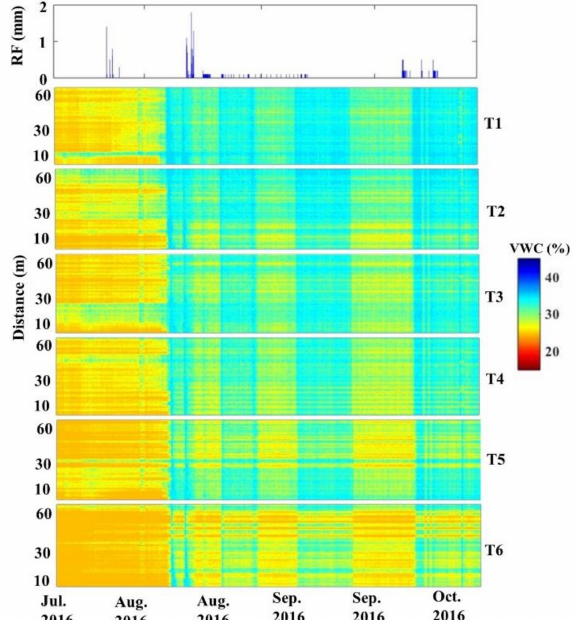
Figure 8. Variation of soil water content at every 0.5 m (location) along the six transects (T1 to T6) during the period from 22nd July 2016 to 17th October 2016 in response to rainfall at 0.05 m